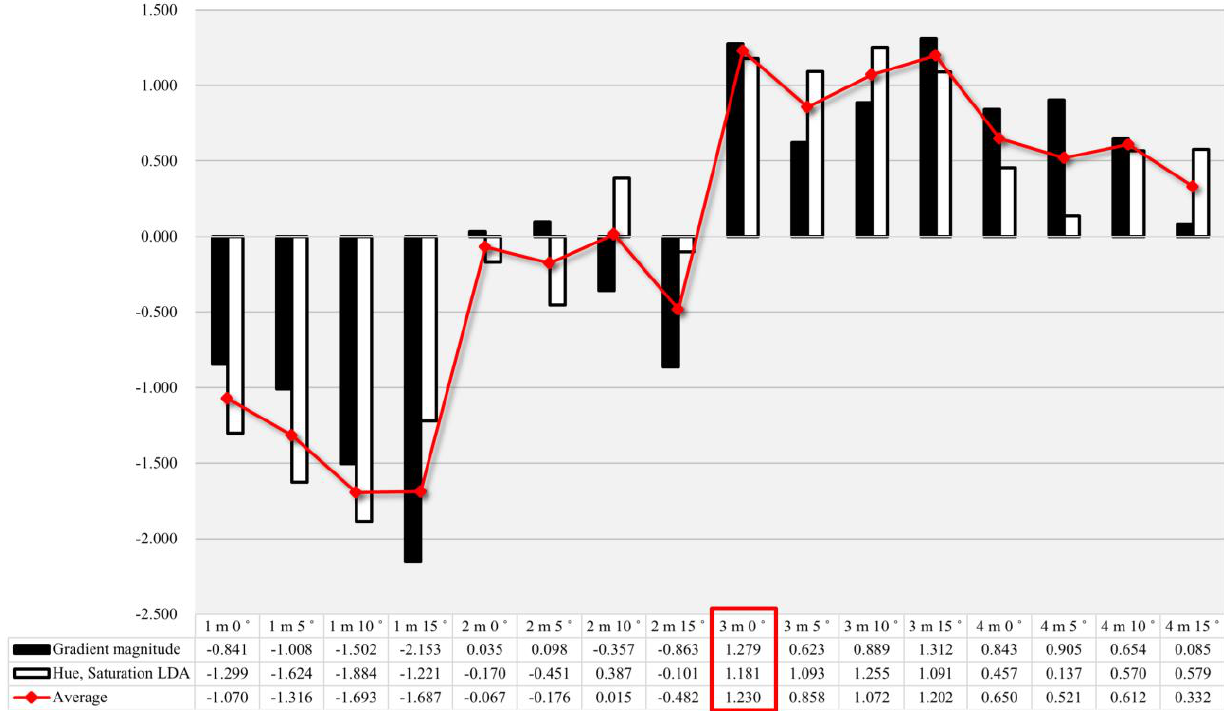
Figure 15. The rest results of recognition degree for RBD based on the selection of shooting height and angle (The red box indicates the height and angle at which the mean of the gradient magnitude, hue, and saturation LDA is the highest).